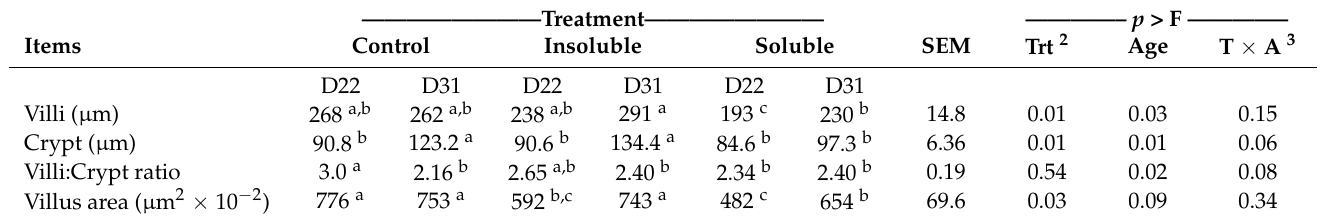
Table 4. Intestinal morphology in pigs fed insoluble or soluble gruel creep diets, measured before (D22) and after (D31) weaning, compared with non-creep-fed controls 1